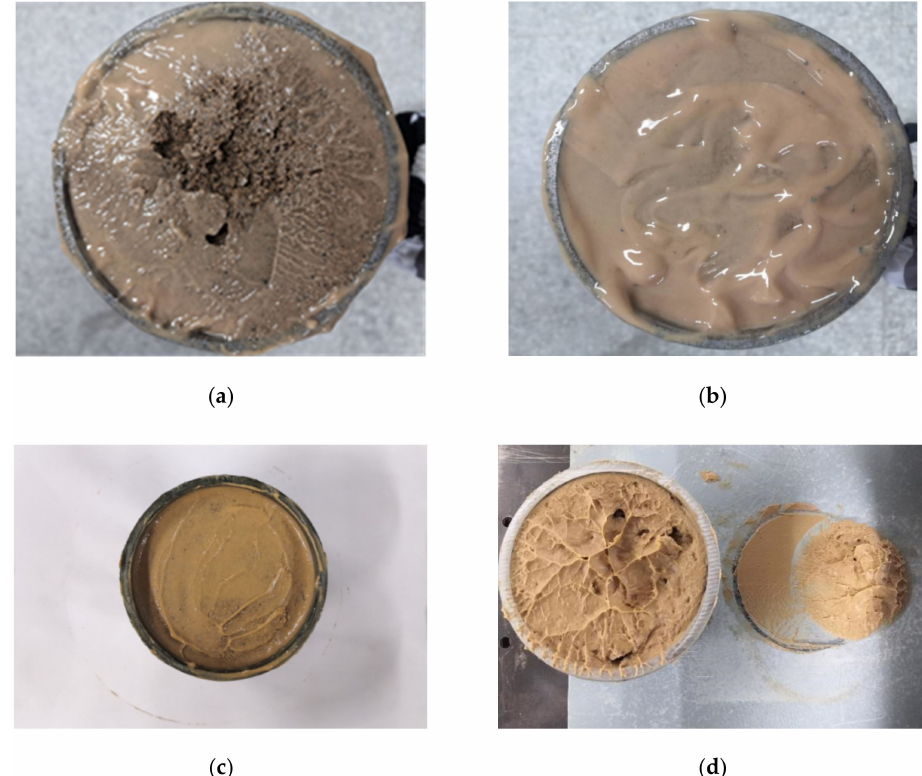
Figure 6. Friction characteristics of the pipe–soil interface with different slurry concentrations. ( a ) Shear failure surface of slurry with a concentration equal to 12%. ( b ) Shear failure surface of slurry with a concentration equal to 14%. ( c ) Shear failure surface of slurry with a concentration equal to 20%. ( d ) Shear failure surface of slurry with a concentration equal to